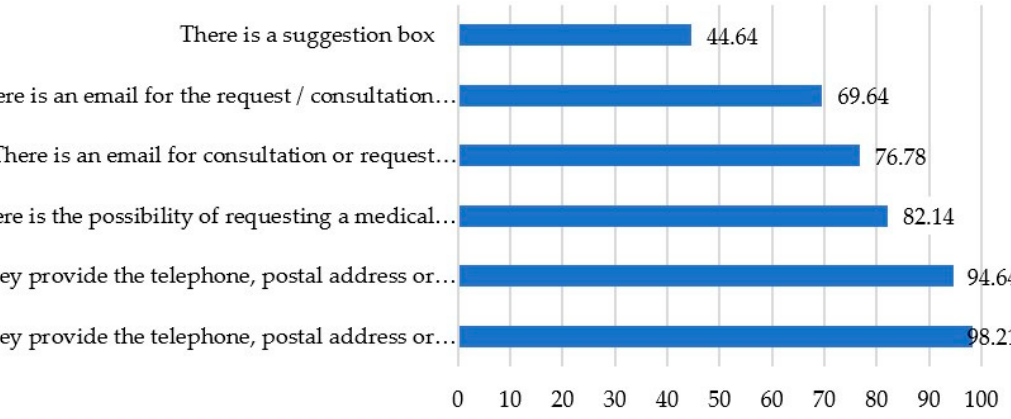
Figure 3. Representation in percentages of “Interactivity and interactions” indicators for all hospitals from the sample.